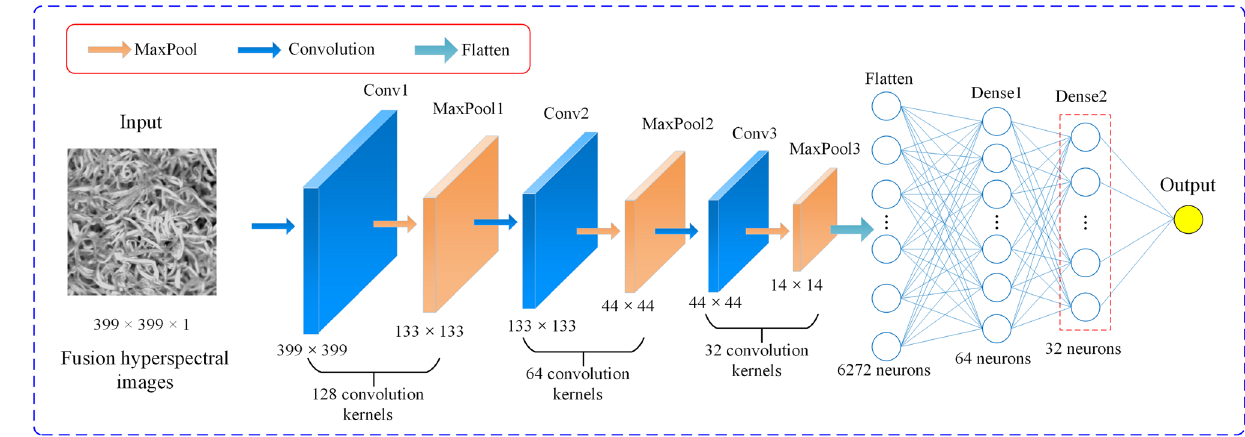
Figure 2. The Structure of 2D-CNN.